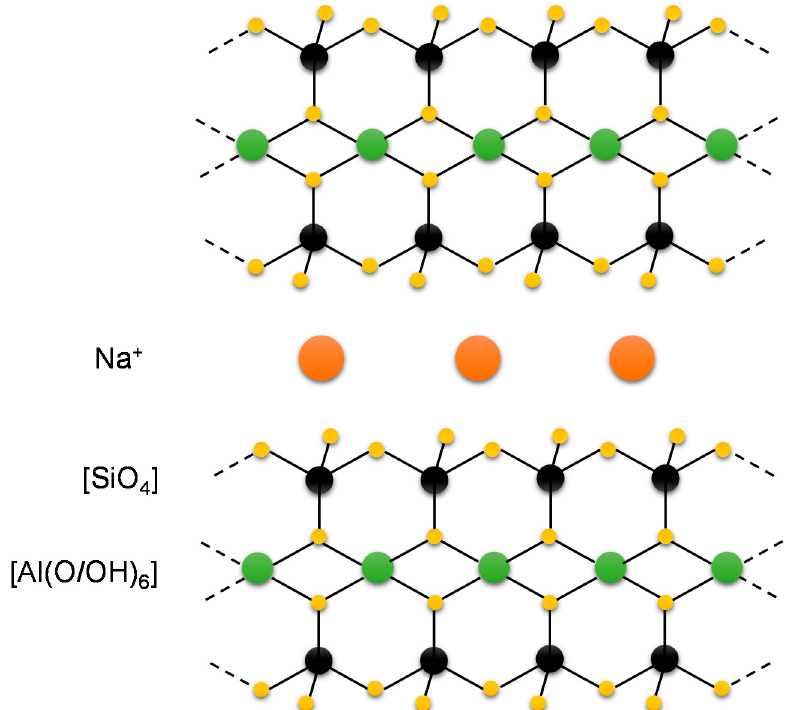
Figure 2. Schematic representation of the three-layer platelet formed by two layers of silicon oxygen tetrahedra and aluminium hydroxide sheet in sodium bentonite montmorillonite layer and sodium exchangeable cations, between adjacent platelets.